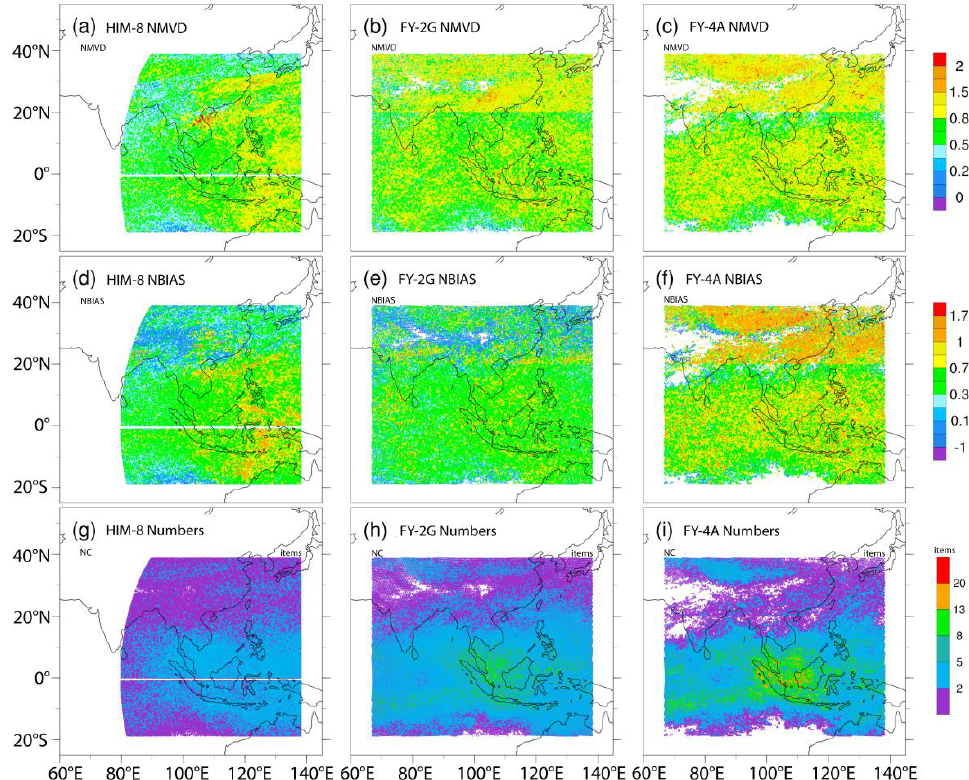
Figure 9. The spatial pattern plots of normalized mean vector differences (NMVD) ( a – c ), normalized speed bias (NBIAS) ( d – f ), and the numbers of collocations ( g – i ) in the high-level averaged of IR AMVs in December 2018 when IR AMVs from FY-2G, FY-4A, and HIMA-8 were collocated with NCEP FNL wind analysis.